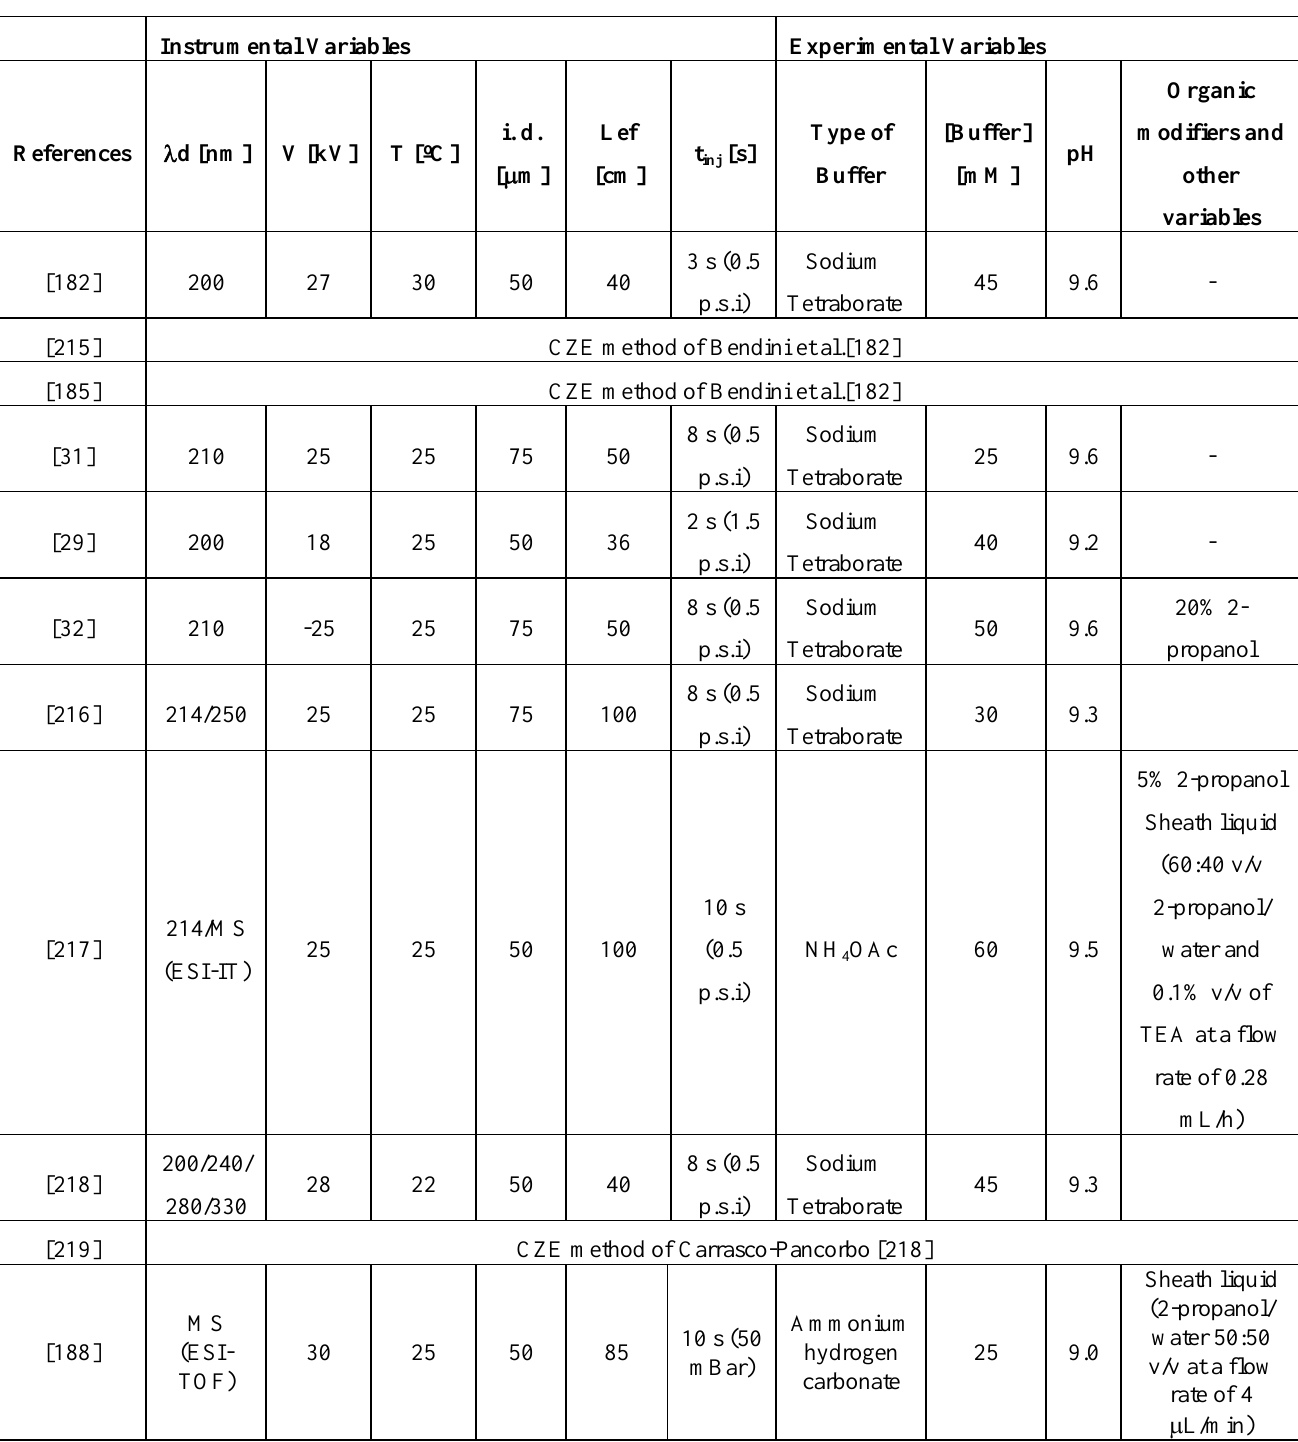
Table 4. Summary of optimized conditions of capillary electrophoresis methods where VOO samples are analyzed. V, voltage; T, temperature, i. d., internal diameter of capillary; L , effective length of capillary; [Buffer]; buffer ef